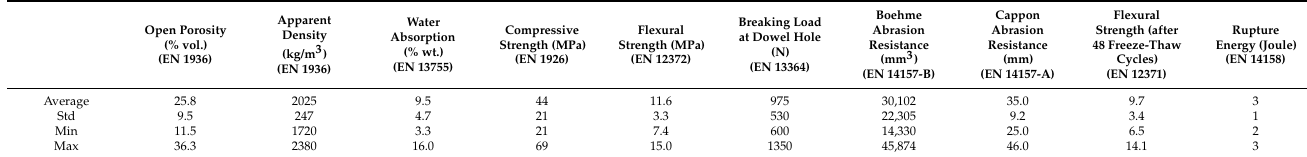
Table 4. Average values of physical mechanical properties determined for other limestones.